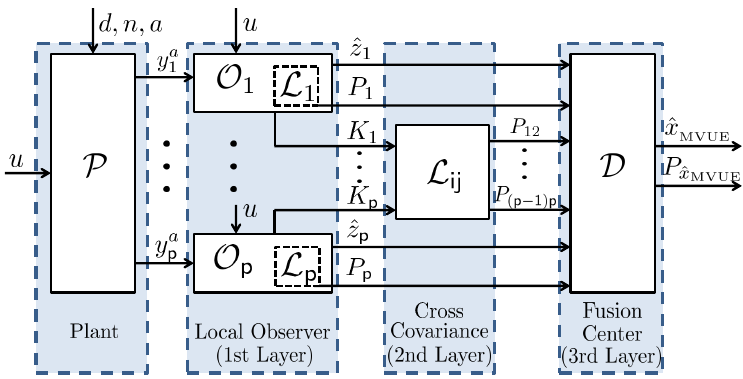
Figure 1. Structure of decentralized multi-sensor information fusion Kalman